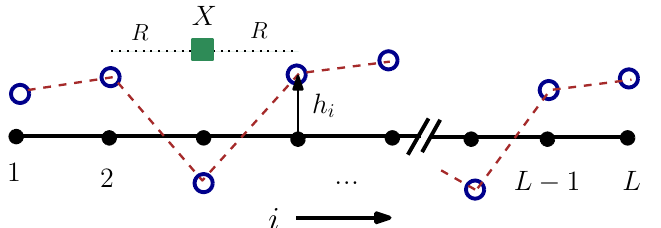
Figure 6: Schematic representation of the random walker coupled to a Rouse poly- mer model on a lattice, used for numerical simulations. The dashed red line indicates the polymer connecting L monomers, represented as circles. The walker (green square) changes its position X by jumping to one of its nearest neighbouring sites with a rate that depends on the displacement h of the monomers within the range i X − R ≤ i ≤ X + R